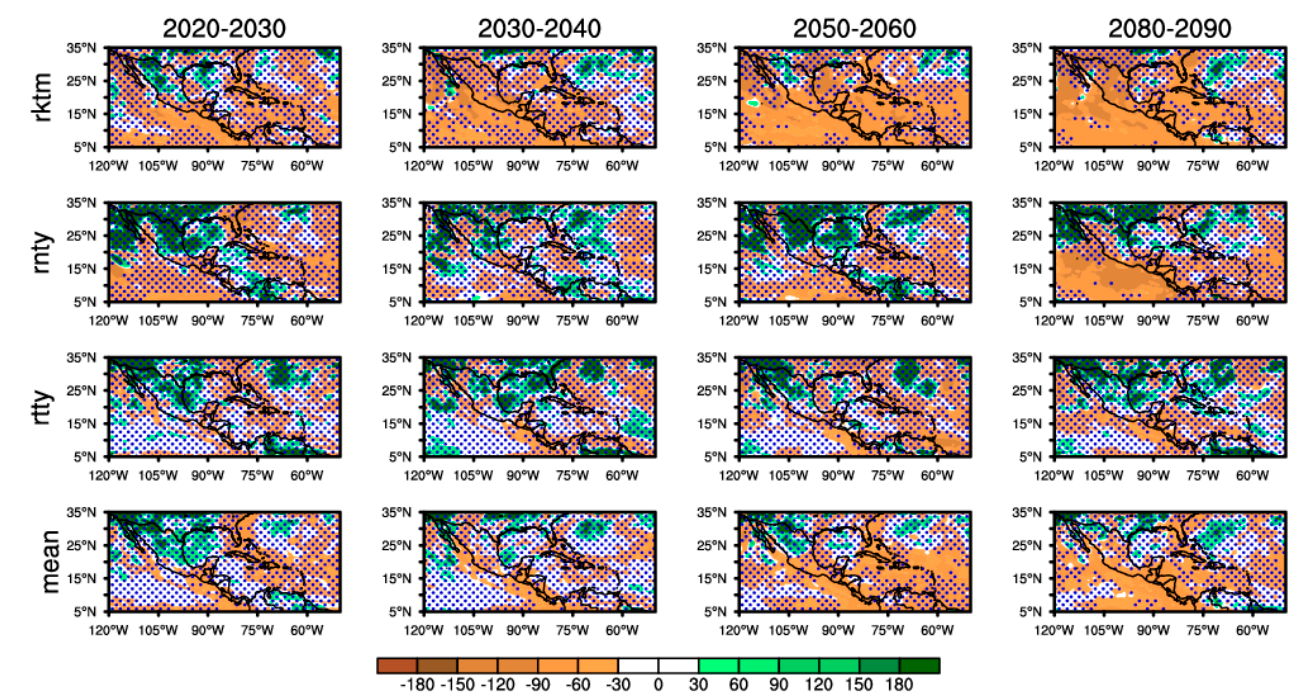
Figure 6. Mean annual percent change (%) in precipitation associated with tropical cyclones in the future ensemble runs with respect to the reference period (1990–2000). The dotted regions indicate a 95% significance level applying the Kolmogorov–Smirnov two-sample test.